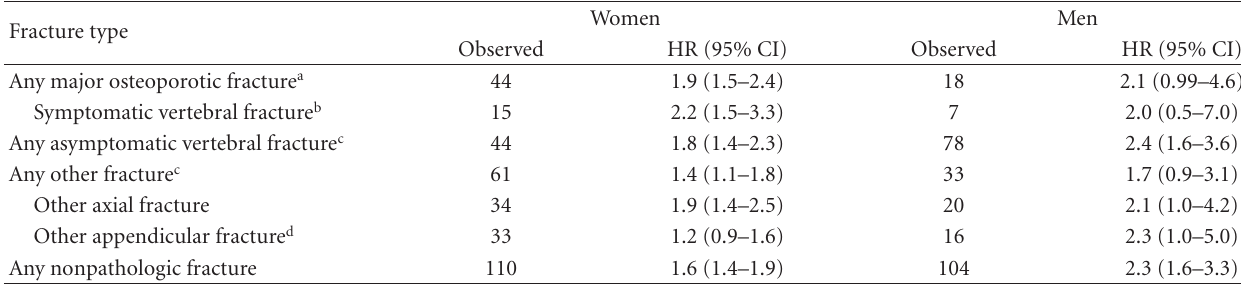
Table 4: First nonpathologic fracture of each type observed and hazard ratio (HR) per 10% increase in the full 10-year US FRAX (FN BMD) probability among Rochester, MN women and men ≥ 40 years of age, by type of fracture outcome.